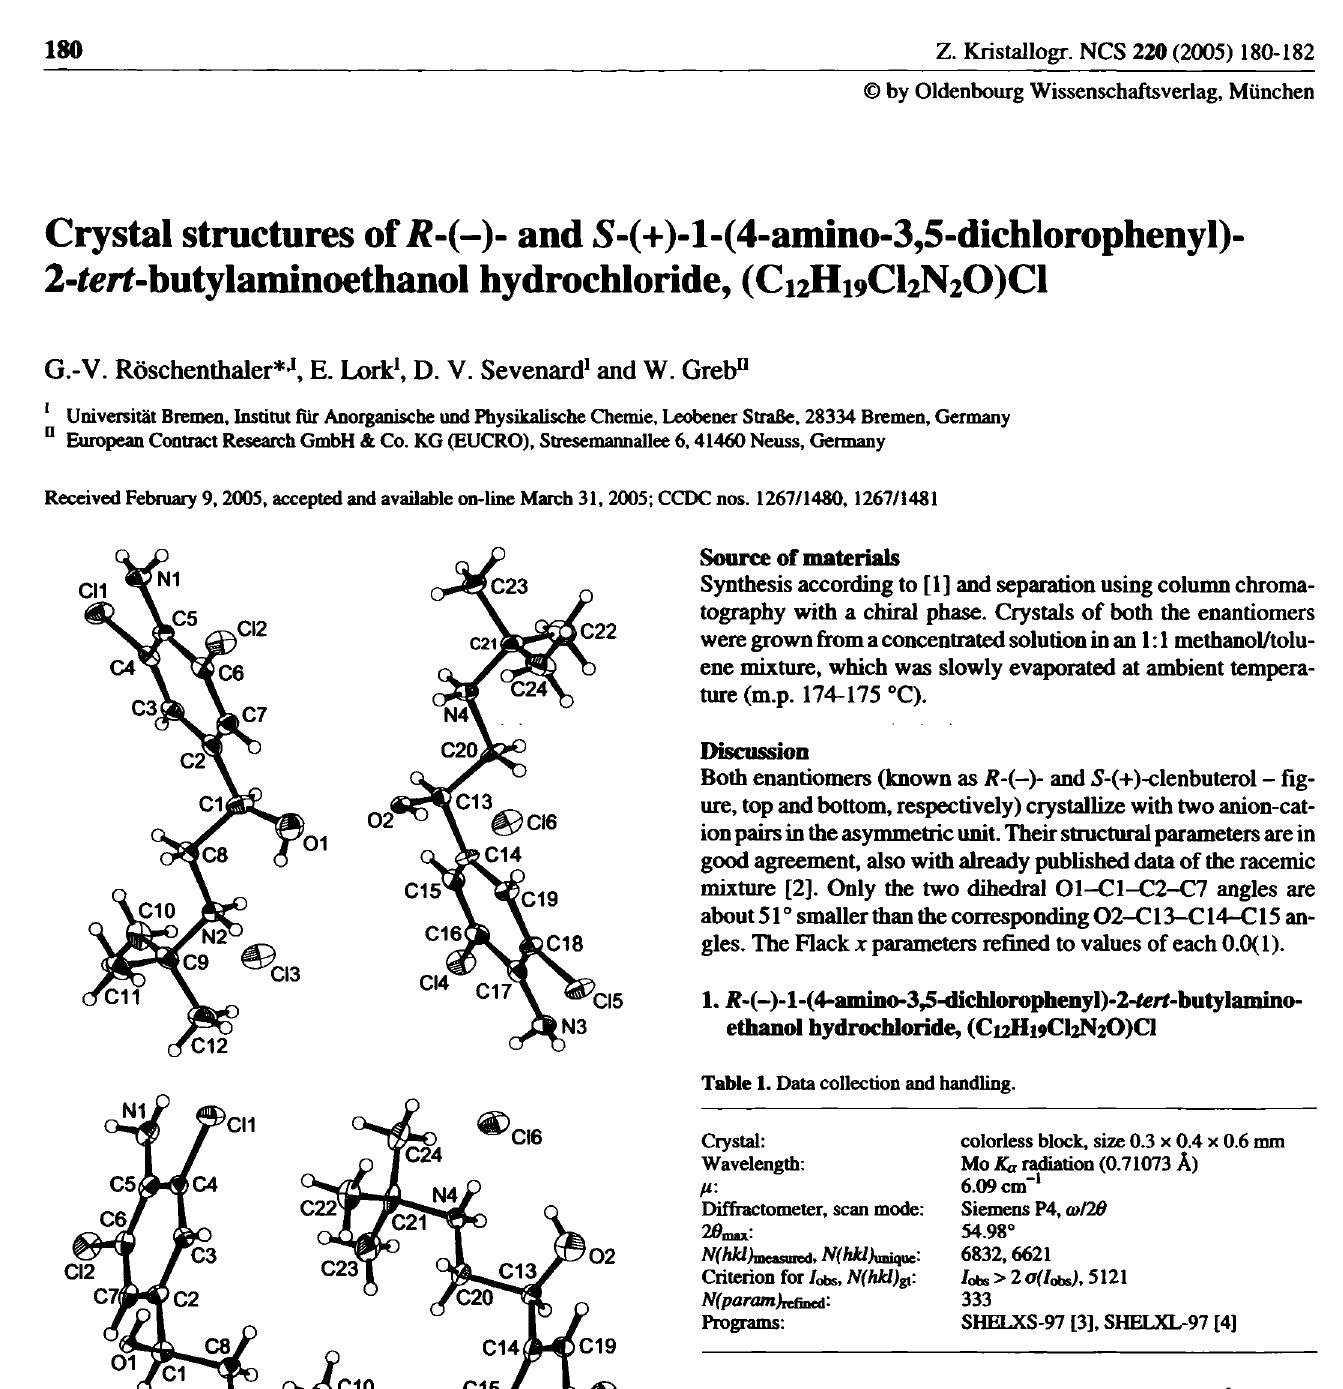
Table 2. Atomic coordinates and displacement parameters (in Ä 2